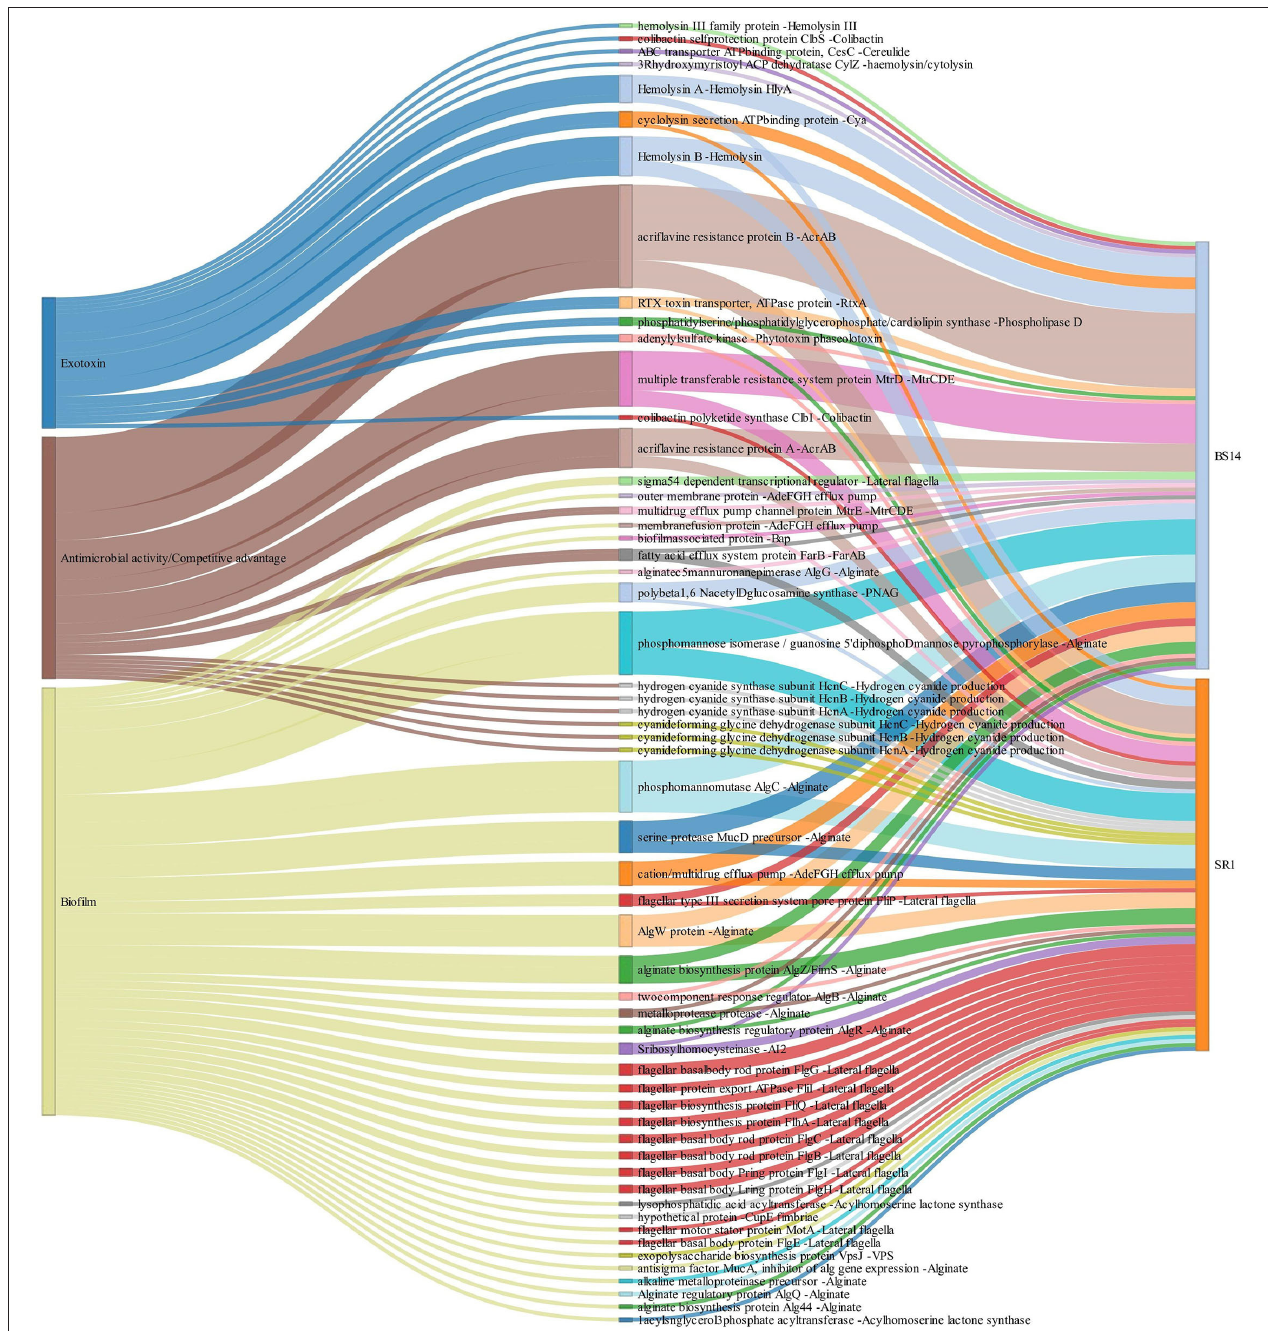
FIGURE 7 | Exploration of the biofilm, antimicrobial activity/competitive advantage, and exotoxin category of VFDB in BS14 and SR1 samples.